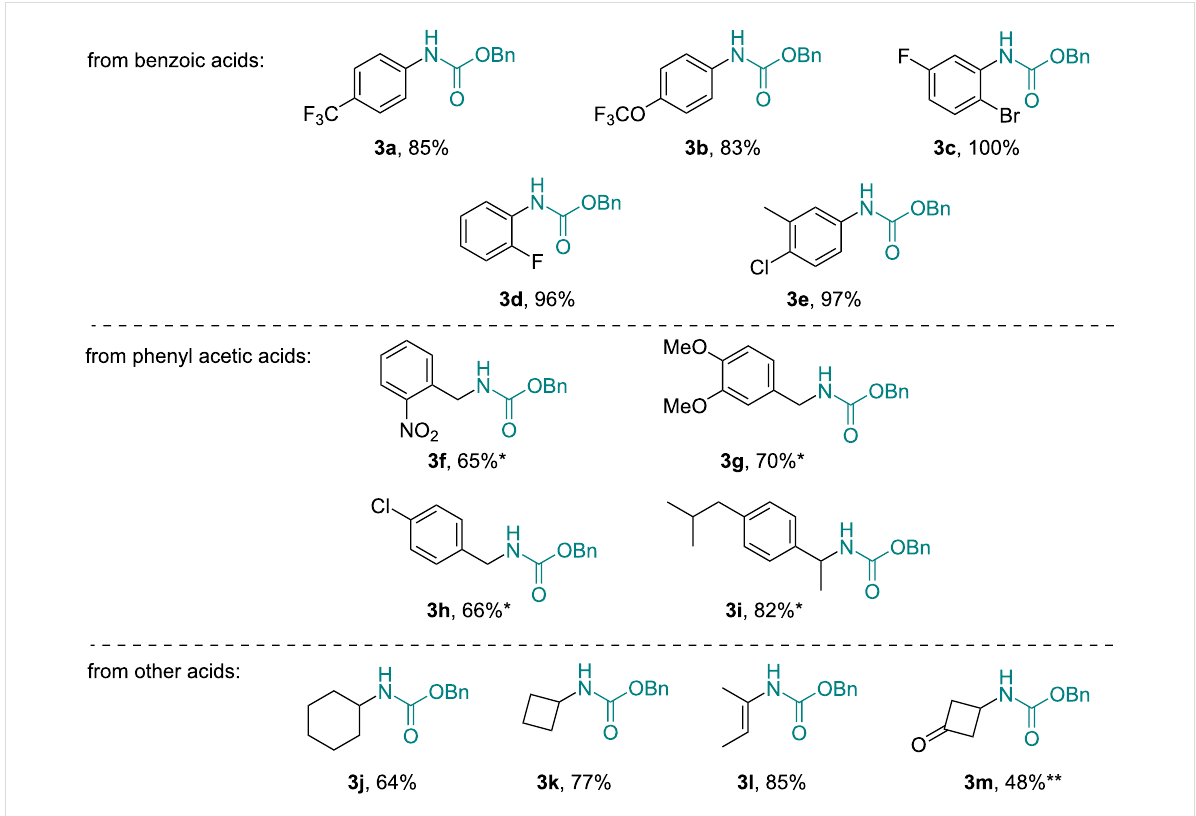
Figure 1: Scope of Cbz-carbamate products obtained via flow process (* t Res = 60 min, ** T = 80 °C; isolated yields after removal of BnOH, vide infra).